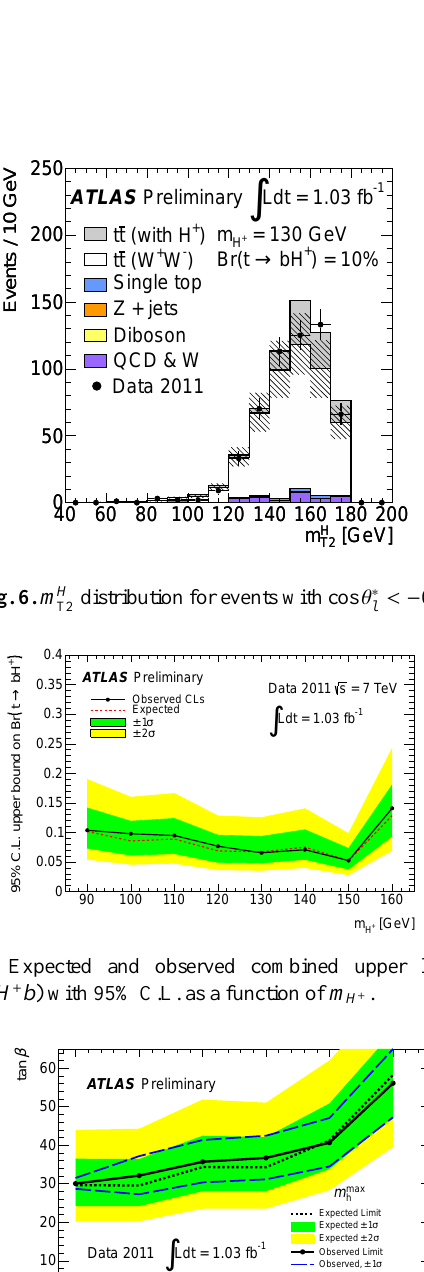
Fig. 8. Combined limits for H + production in the m H + -tan β plane ( m max H